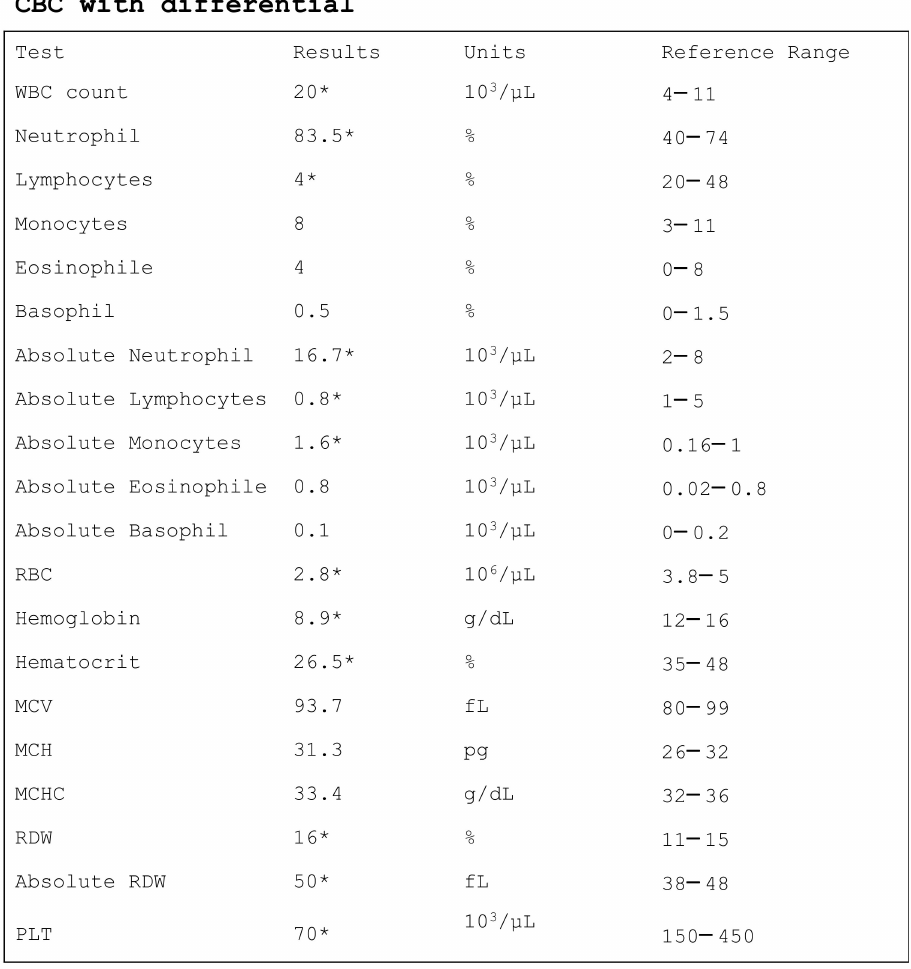
Figure 2. The CBC of an adult patient with sepsis. WBC, white blood cells; RBC, red blood cells; MCV, mean cell volume; MCH, mean corpuscular hemoglobin, MCHC, mean cell hemoglobin concentration, RDW, red distribution width; PLT, platelet. * indicates values out of reference range. Notably, reference ranges change according to the instrument